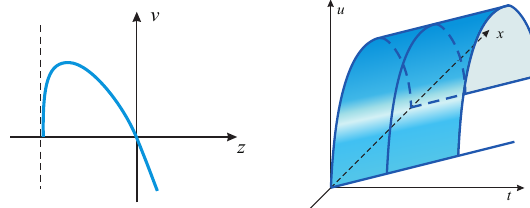
Figure 6. Solution v ( z ) and the